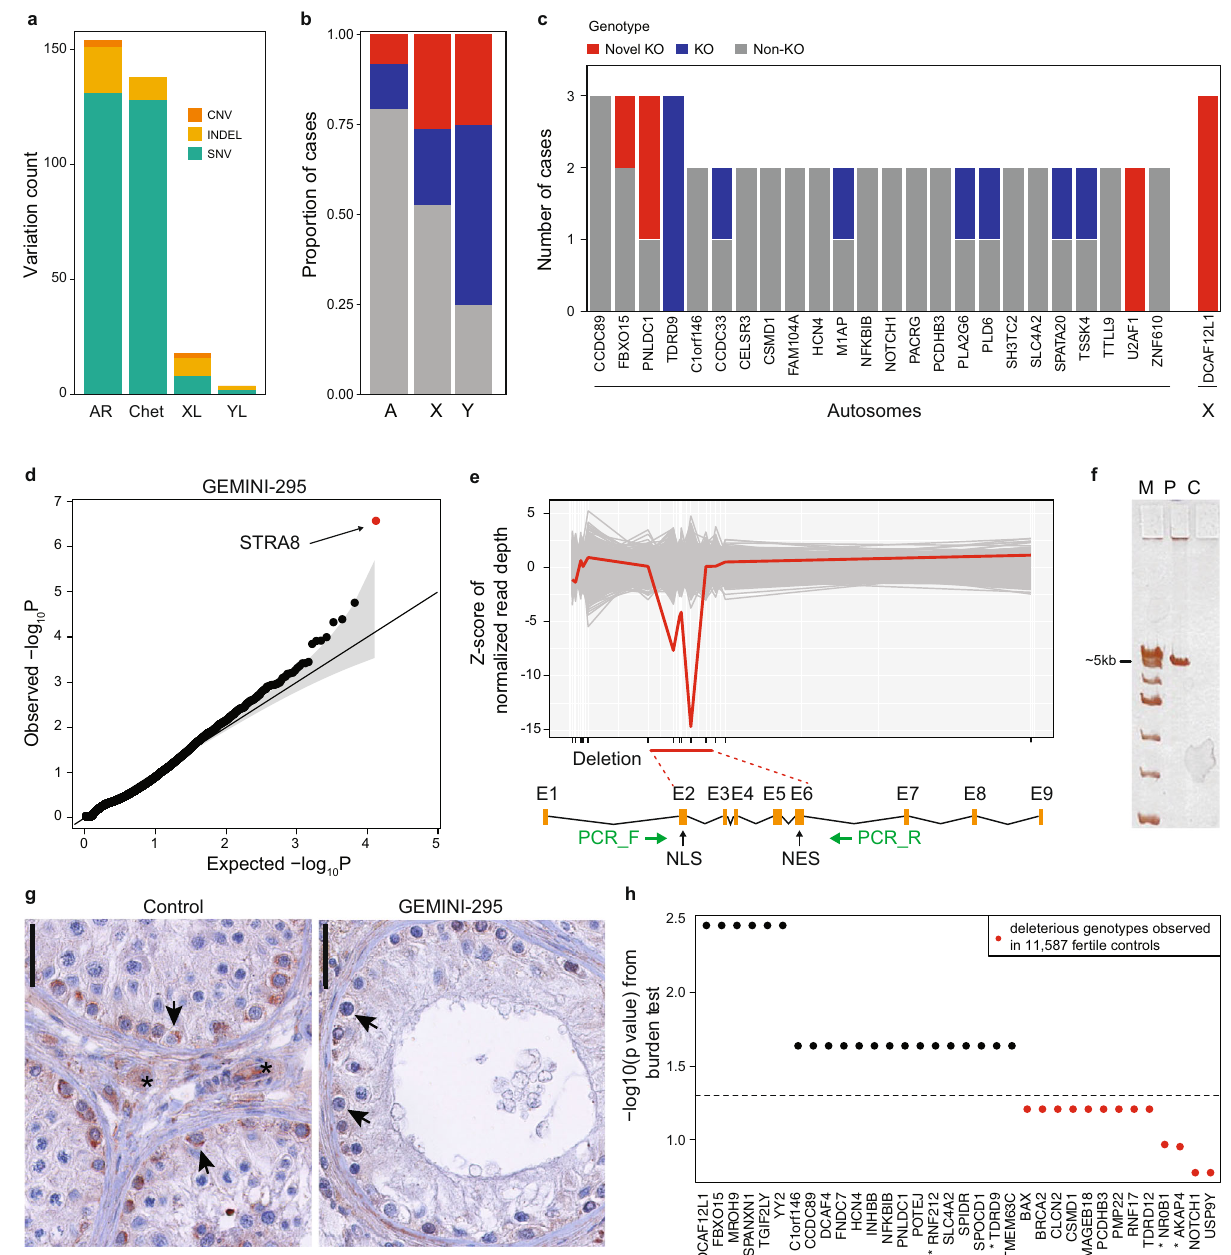
Fig. 2 | Variant prioritization and burdentesting inNOAcases. a Distribution of the prioritized variation types across inheritance modes. AR autosomal recessive, Chet Compound heterozygous, XL X-linked, YL Y-linked. b Predicted hemizygous loss-of-function genotypes appear to be enriched on sex chromosomes compared tobiallelicloss-of-functiongenotypesonautosomes(A)(Fisher ’ sexact p =0.018for chrX and p = 0.032 for chrY vs A). * p < 0.05. c Summary of all genes with multiple case fi ndings in the GEMINI cohort. d PSAP p values of all variants detected in patient GEMINI-295, the carrier of the biallelic STRA8 deletion. STRA8 CNV (the smallest p value)wasprioritizedasthemostlikelycauseofNOAinGEMINI-295.The gray area represents the 95% con fi dence interval. e Z-scores of normalized read depth of exome sequencing data around the STRA8 locus, plotted against the STRA8 gene model. NLS nuclear localization; NES, nuclear export signal. Green arrows, PCR primers. f PCR spanning the predicted deletion region yielded a short